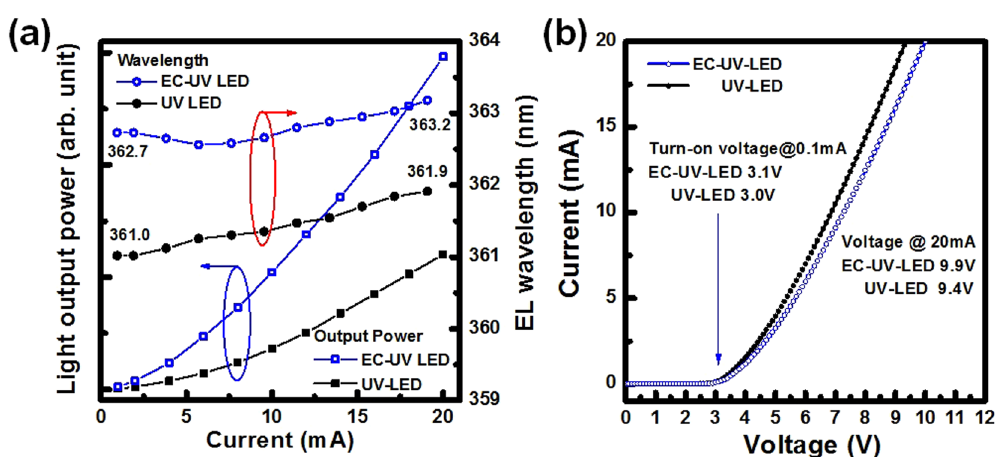
Figure 6. ( a ) Light output power and the peak wavelength of the EL spectra of both of the LED structures were measured. After the embedded reflector structure was formed, the EL emission peak wavelengths of the EC-UV LED were slightly redshifted compared with the non-treated UV-LED structure. ( b ) The I–V curves and the turn-on voltage of both devices are